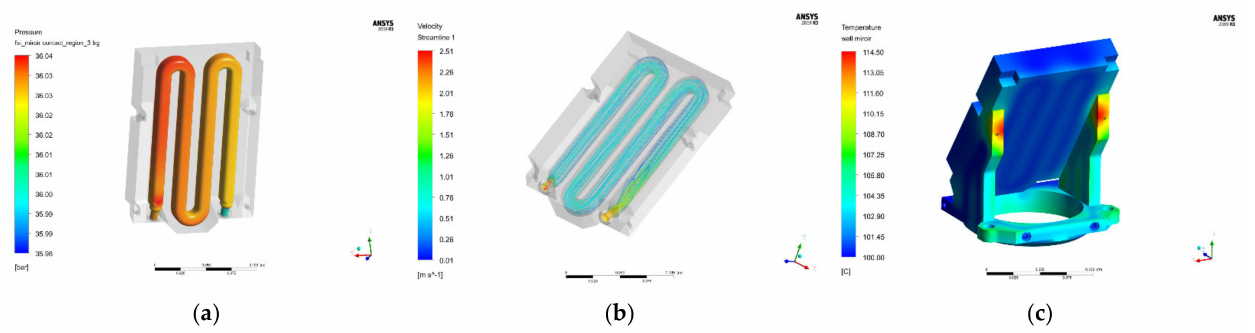
Figure 10. ( a ) Pressure at fluid–structure interface in the mirror. ( b ) Streamline velocity inside fluid mirror body. ( c ) Temperature profile in solid